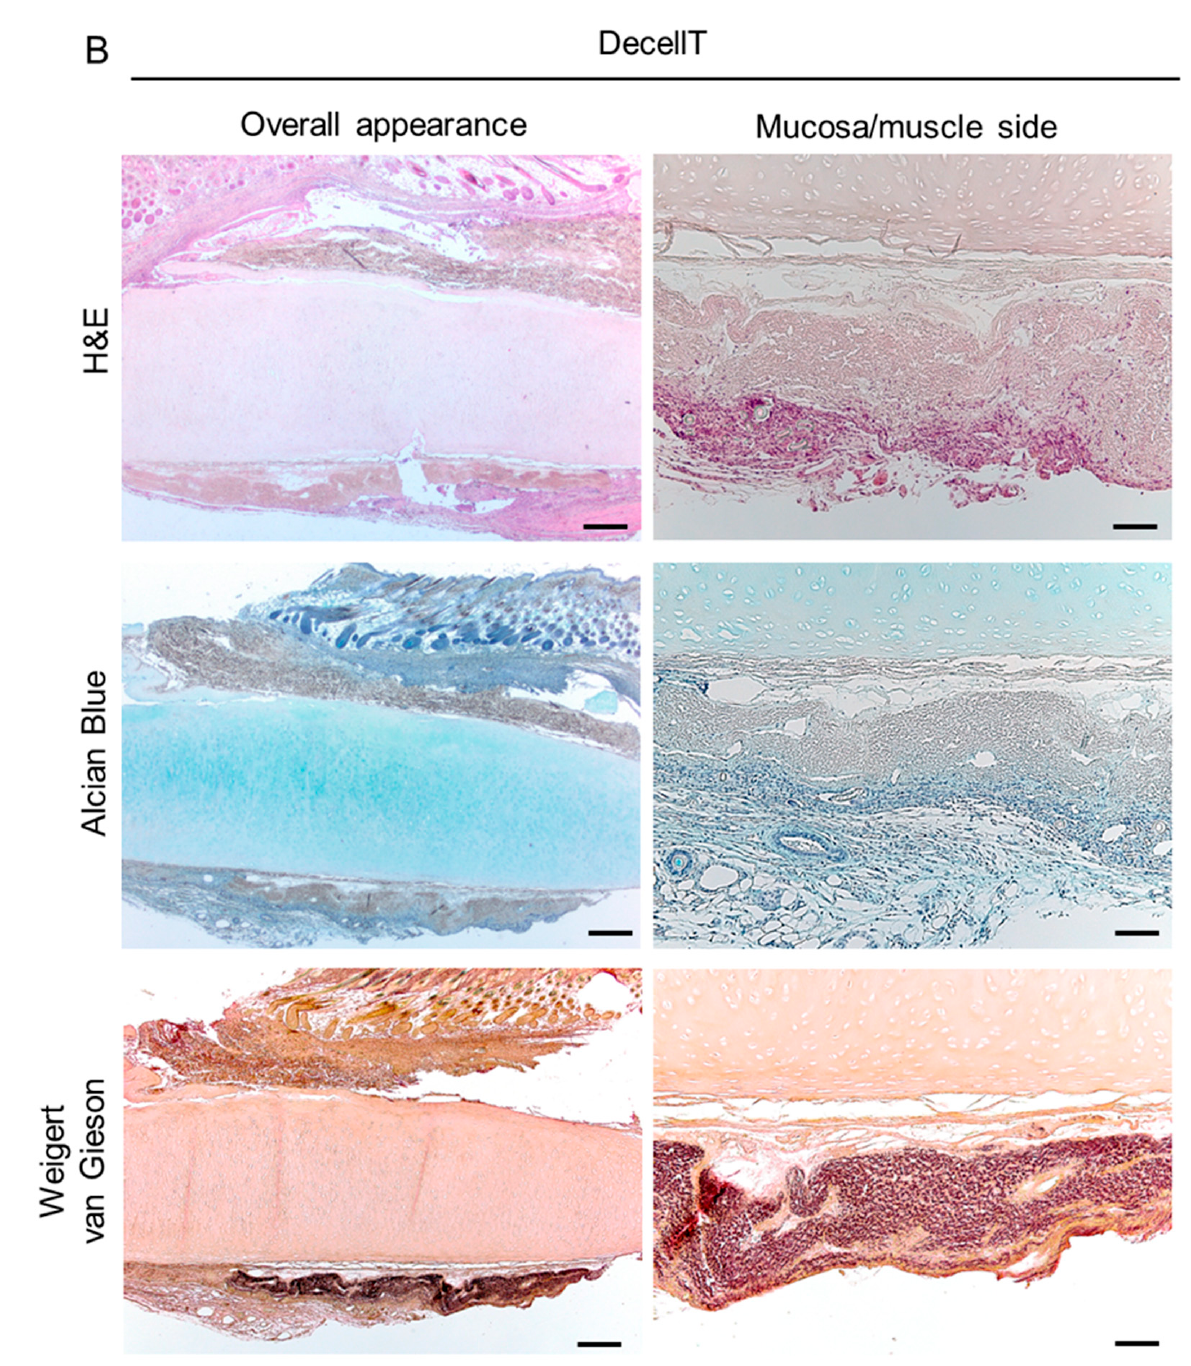
Figure 14. Histological characterization of the explants by haematoxylin end eosin (H&E), Alcian Blue and Weigert van Gieson stainings. Both the overall appearance of the explants with the surrounding tissues and the mucosa/submucosa side were highlighted for the cryopreserved ( A ) and decellularized ( B ) tracheas (CryoT and DecellT, respectively). Scale bars: 400 µm (overall appearance); 100 µm (mucosa/muscle side).